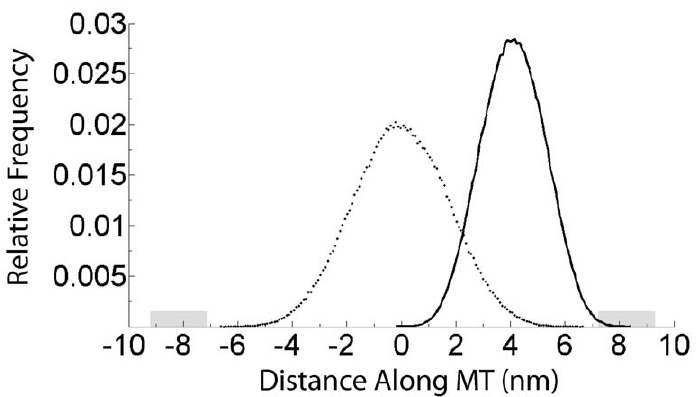
Figure 3. Stationary Distribution Profile of Tethered Head. Stationary positional distribution of the tethered Kinesin-1 motor domain during its diffusive search using the Increasing Stiffness neck linker model. Dotted line shows state before ATP binding (State 2 in Figure 1) where both neck linkers are disordered and there is no positional bias of the tethered head. Solid line shows state following ATP binding (States 3 and 4 in Figure 1) where docking of one neck linker causes a 4 nm displacement toward the microtubule plus-end and diffusion is tethered by remaining neck linker. Note that before neck linker docking the free head cannot reach the next microtubule binding site (grey zone), while after neck linker docking the free head spends only a small fraction of the time ( , 1%) near the binding site.